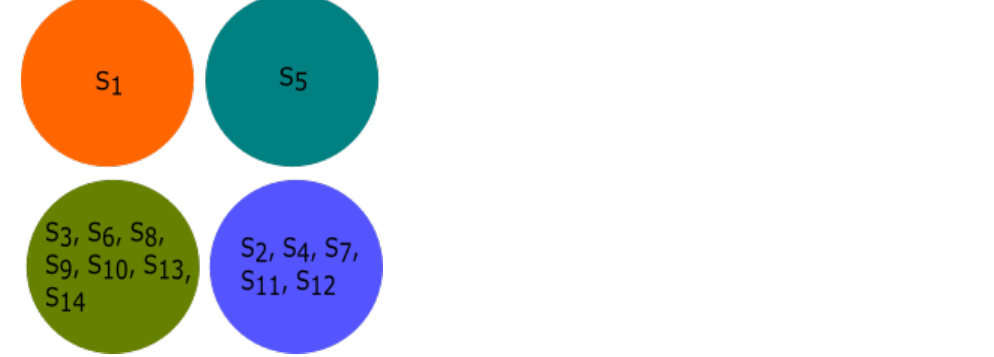
Figure 10. Clusters based on the Hurst exponent using the K-means algorithm. Here, S i indicates the species name as specified in Table 1.